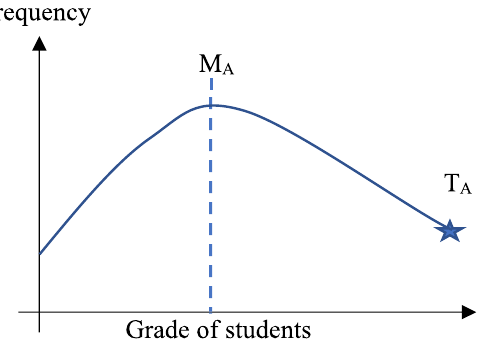
Fig. 2 Bell distribution of students grads Fig. 3 Changes in grads at teaching